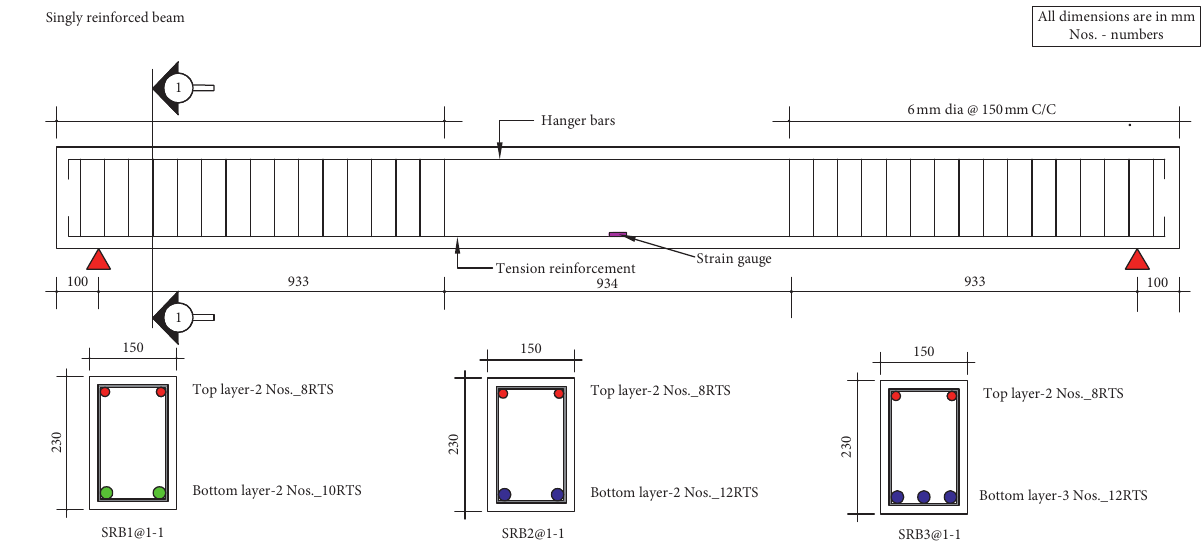
Figure 2: Reinforcement details and strain gauge location for SRB (S1, S2, and S3).